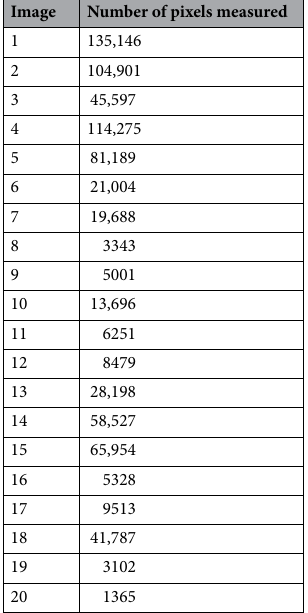
Number of pixels measured Image Using